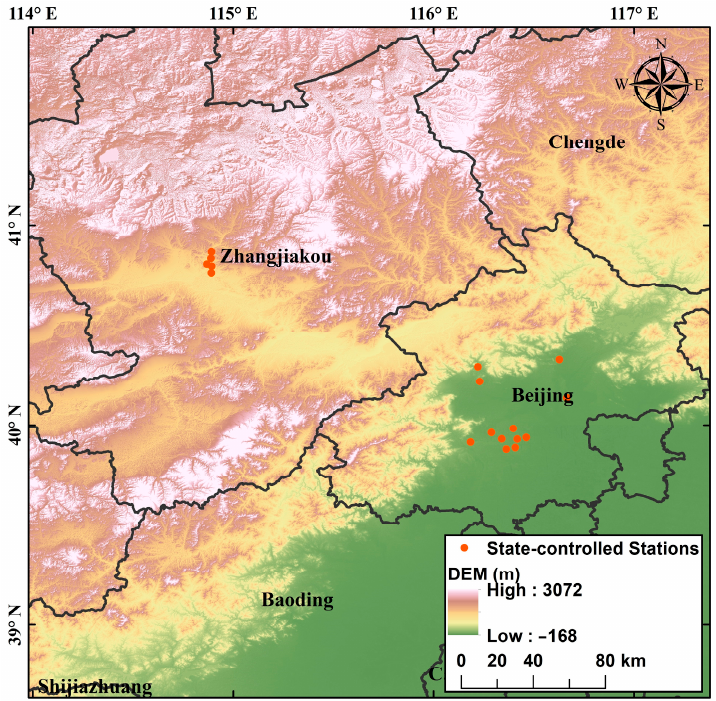
Figure 1. Locations of observation stations in Beijing and Zhangjiakou. Hourly surface meteorological data, including wind speed (WS), wind direction, temperature, and relative humidity (RH), were obtained for Beijing and Zhangjiakou